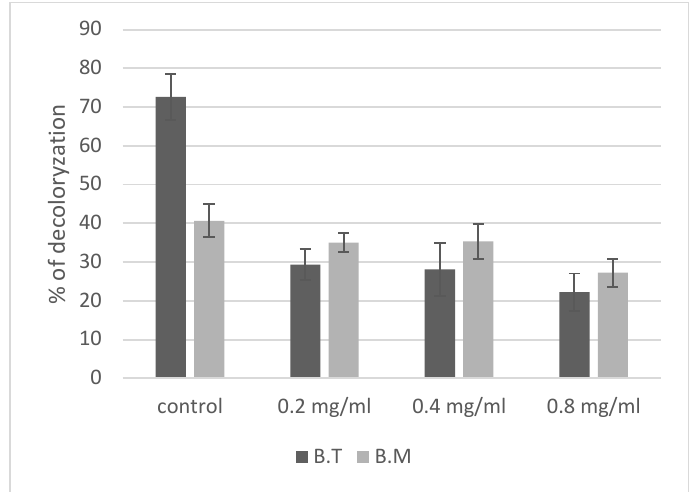
Figure 5. Effect of ZnO NPs on decolorization of Evans blue by cells of Bacillus sp. The concentration of ZnO NPs statistically significantly influences decolorization of Evans blue, and the type of strain influences its decolorization in the presence of ZnO NPs. B.T. — Bacillus thuringiensis, B.M. — Bacillus megaterium .